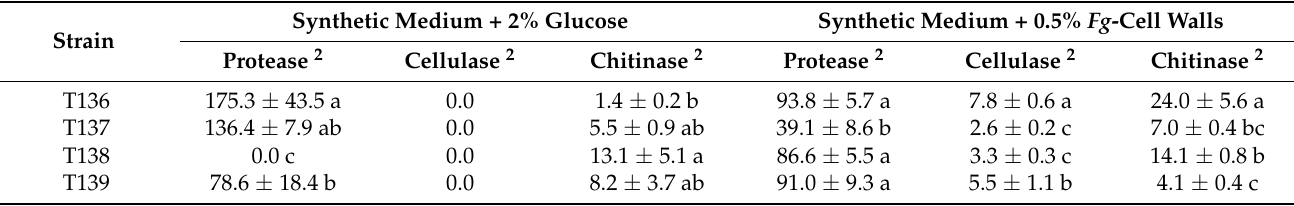
Table 3. Protease, cellulase, and chitinase activities that were measured for four Trichoderma strains ( T. harzianum T136,